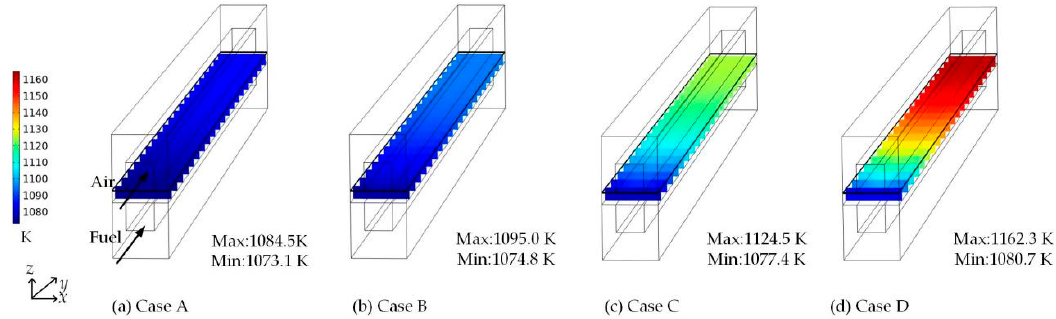
Figure 6. Distribution of temperature under different methane Pre-Reforming percentages.